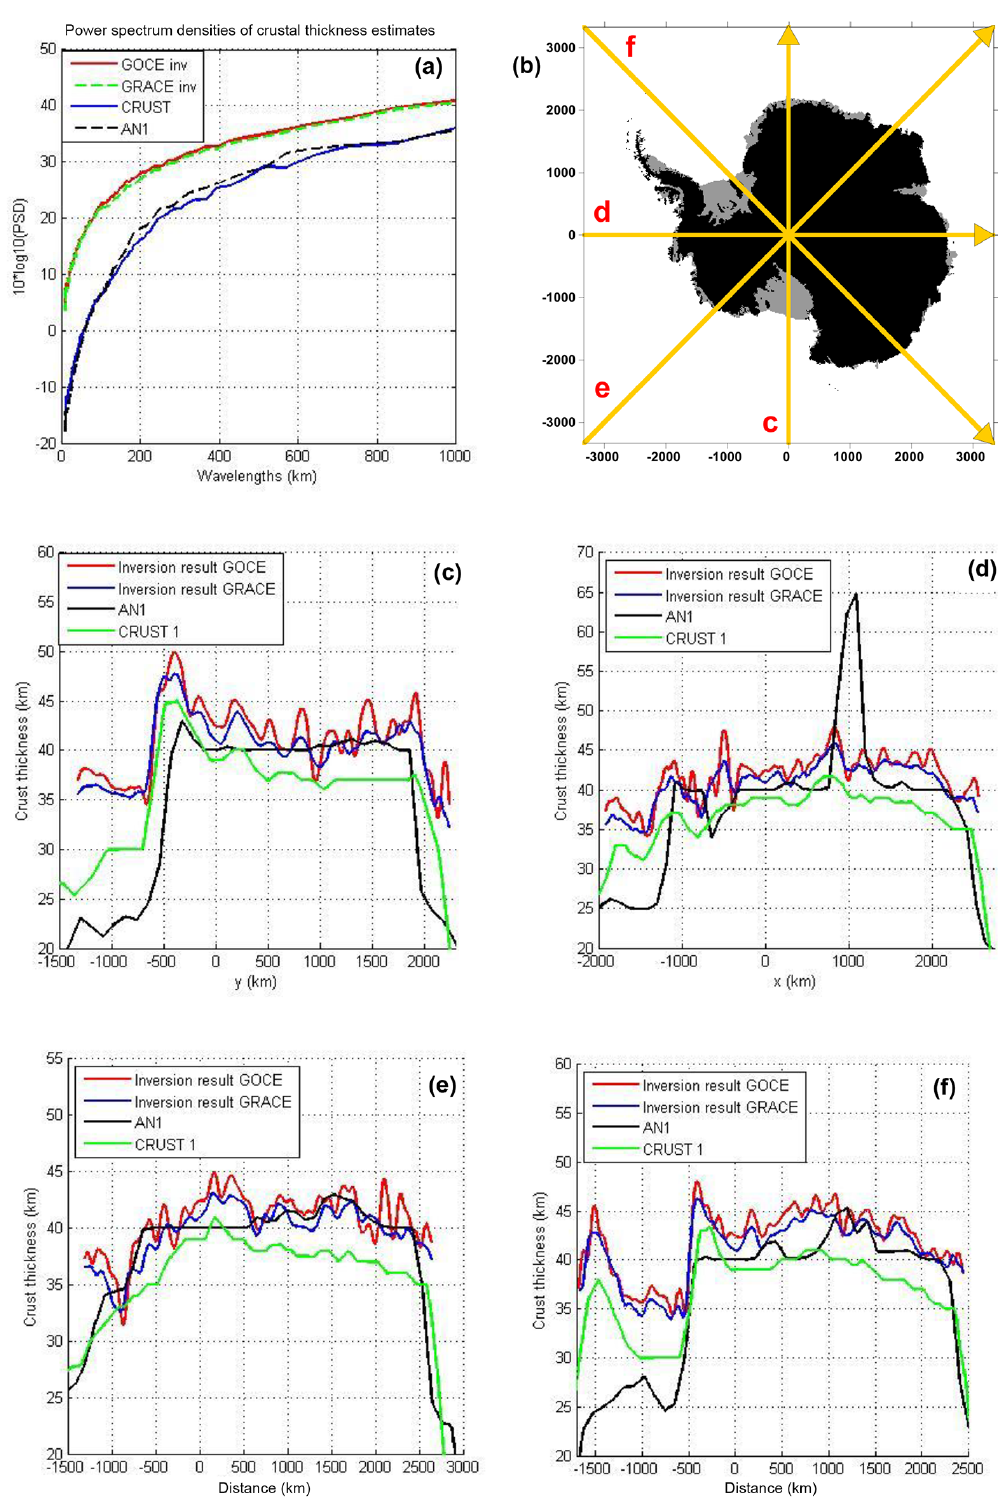
Figure 7. Spectral analysis crust thickness models (a) and their thickness variations over four profiles (shown with yellow lines in panel b ). The Antarctica map is converted in a cartesian x − y coordinate system. The profiles are (c) parallel to y , (d) parallel to x , (e) x = y and (f) x = − y . The South Pole is located at